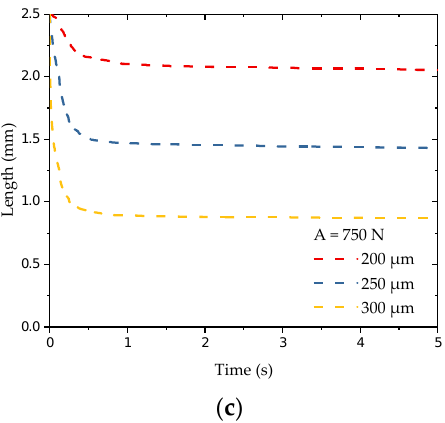
Figure 7. Predicted 𝐿 𝑛 of simple shear flow simulation at varying fiber critical breaking curvature with three excluded volume force constants 𝐴 from: ( a ) 250 N, ( b ) 500 N, ( c ) 750 N.